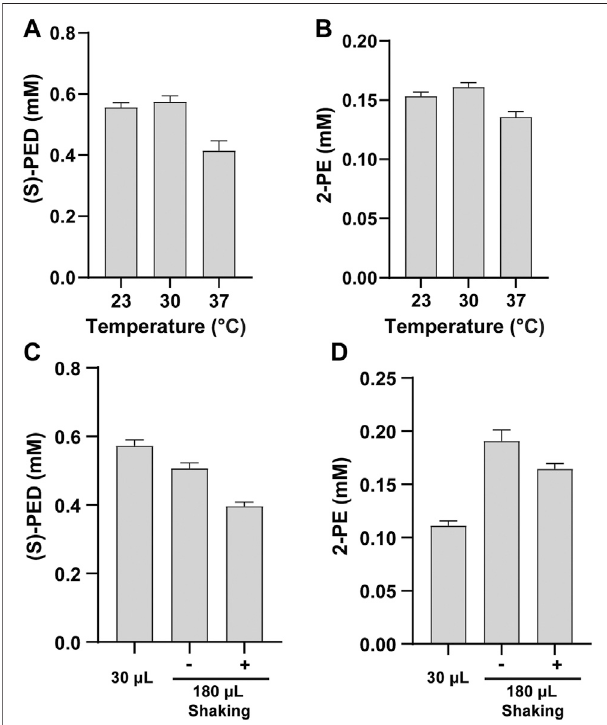
FIGURE 5 | Effects of (A , B) reaction temperature and (C , D) reaction volume on the synthesis of ( S )-PED and 2-PE, respectively. Values show means with error bars representing standard deviations (s.d.) of at least three independent